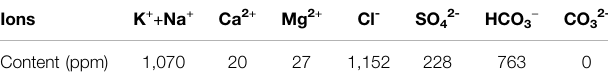
TABLE 1 | The component content of ions in experimental